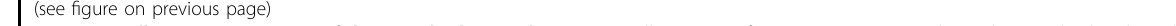
Fig. 3 Overall cryo-EM structures of the S-antibody complexes. a Overall structure of SARS-CoV-2 S in complex with F61 Fab. The tilt angle of RBD is de fi ned by the angle between the long axis of RBD (red line) and its projection on the horizontal plane (black ellipse). Angle between them is indicated. SARS-CoV-2 RBD is colored in cyan, other domains in gray, heavy chain of F61 in magenta and light chain of F61 in violet. Related to Supplementary Fig. S2. b Overall structure of SARS-CoV-2 S in complex with D2 Fab. The tilt angle of RBD is de fi ned by the angle between the long axis of RBD (red line) and its projection on the horizontal plane (black ellipse). Angle between them is indicated. SARS-CoV-2 RBD is colored in cyan, other domains in gray, heavy chain of D2 in orange and light chain of D2 in light orange. Related to Supplementary Fig. S3. c Overall structures of SARS-CoV-2 Omicron S in complex with F61 Fab and D2 Fab. Color schemes are the same as a and b . Related to Supplementary Fig. S4. d Structural superposition of RBD-fab and RBD-ACE2 (PDB ID: 6M0J) structures and the footprints of F61, D2 and ACE2 on the RBD, and structure of Omicron-RBD- F61-D2 with footprints of F61 and D2 on the RBD. ACE2 is colored in blue. The footprints of F61, D2 and ACE2 are represented as magenta, orange and blue, respectively. Other color schemes are the same as a and b